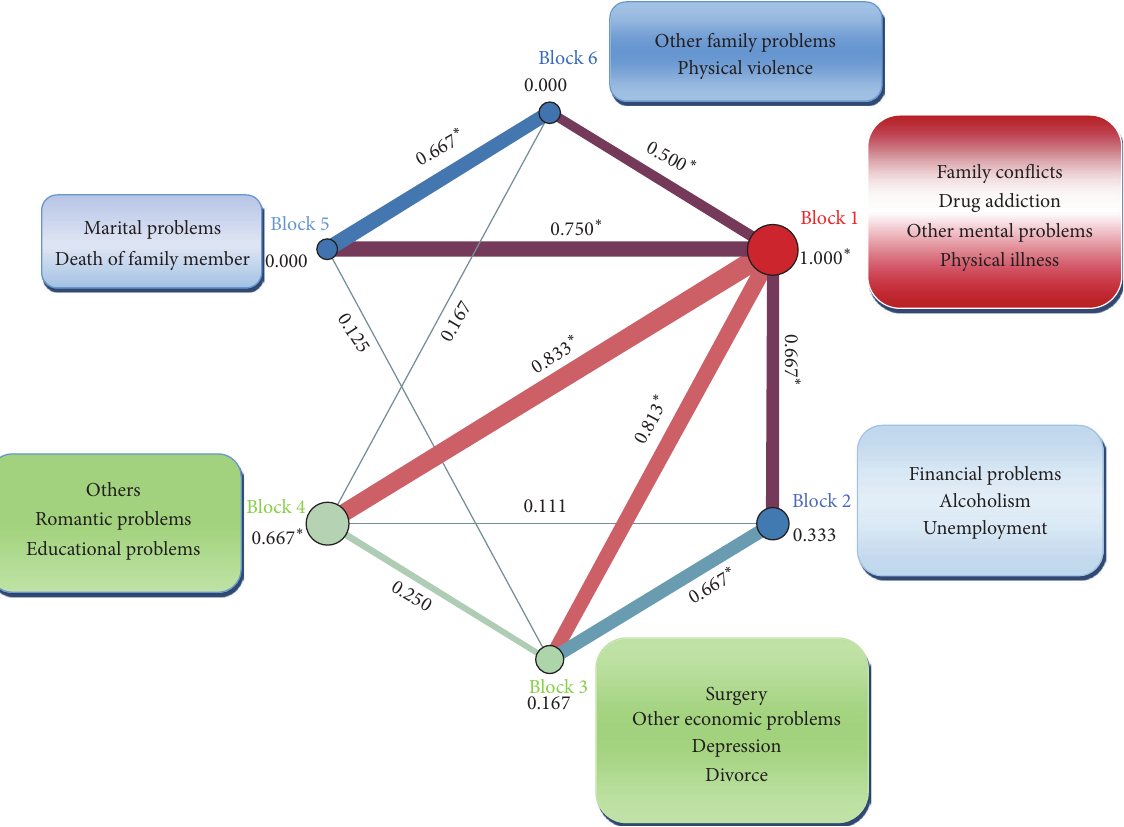
Figure 2: Block modelling in the network of problems preceding deliberate self-poisoning. ∗ Density scores higher than the score of whole